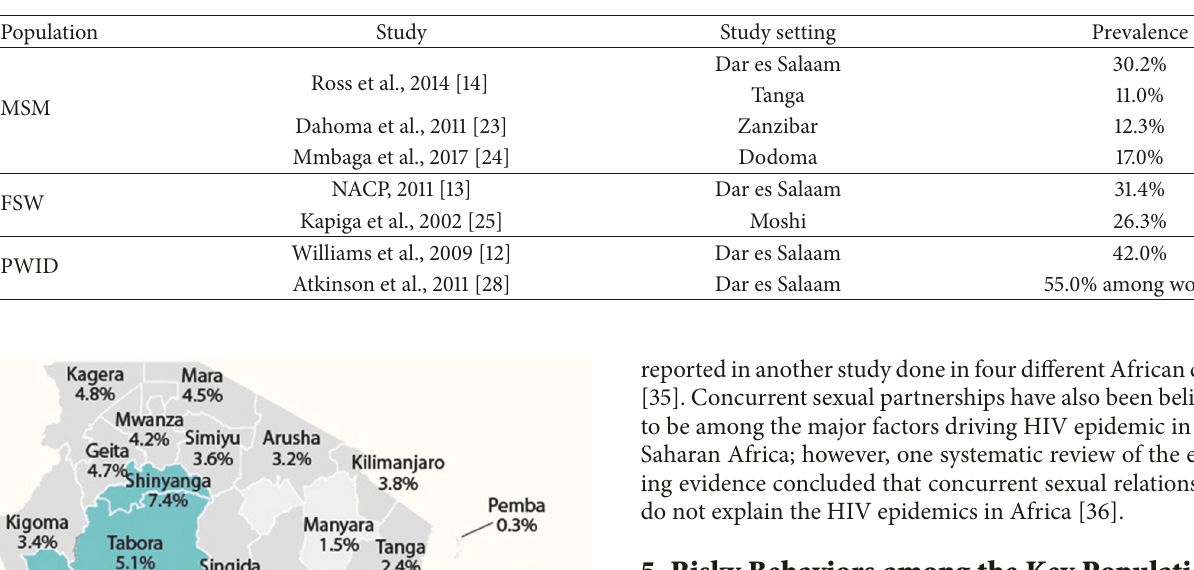
Table 1: Summary of studies on HIV prevalence among the different key populations in Tanzania.